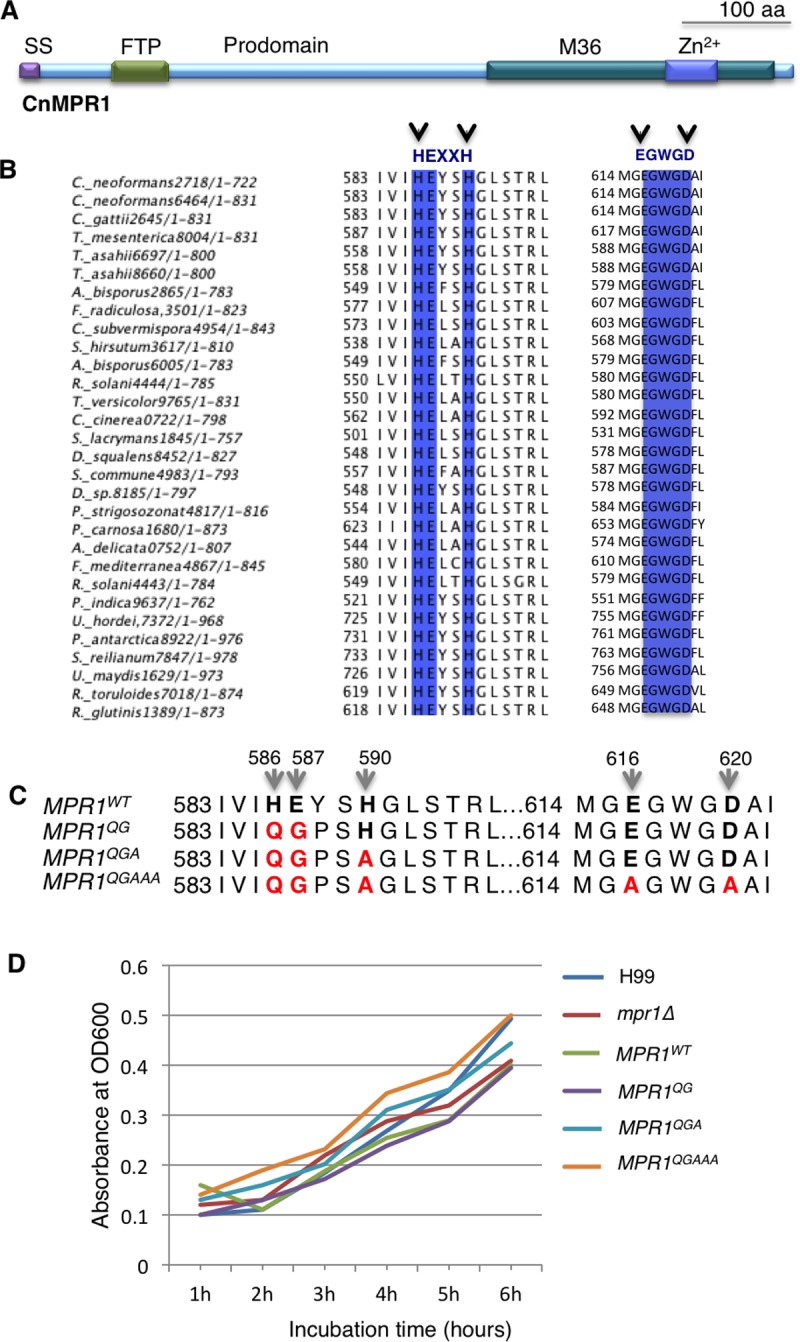
Substitution of conserved amino acids within regions of Mpr1 required for Zn2+ coordination and catalytic activity.(A) The scaled, schematic representation of the predicted structural features of Mpr1 indicates the signal sequence (SS), the prodomain containing a conserved FTP motif and the zinc-binding sites within the M36 catalytic domain. (B) The Mpr1 protein sequence alignment across fungal species revealed strong consensus among amino acids required for coordinating zinc and for catalytic activity (HExxH and ExxxD). (H, histidine; E, glutamic acid; D, aspartic acid). (C) Amino acid sequence depiction of wild type Mpr1 and three zinc-binding site mutants used in the study. MPR1wt is the reconstituted strain (mpr1Δ::MPR1) with conserved H586E587xxH590 and E616xxxD620 regions. The MPR1QG and MPR1QGA mutants contain amino acid substitutions within the HExxH consensus region as follows: H586Q, and E587G or H586Q, E587G and H590A. The MPR1QGAAA mutant contains substitutions in both HExxH and ExxxD consensus regions as follows: H586Q, E587G, H590A, E616A, D620A. (Q, glutamine; G, glycine; A, alanine). (D) The growth curves of C. neoformans strains expressing the MPR1 mutants demonstrated no significant difference in the growth rates at 37°C suggesting that expression of the MPR1 mutants did not negatively impact the viability of C. neoformans. The description of the MPR1 mutants is detailed above. The H99 strain represents a wild type strain of C. neoformans MPR1WT. The mpr1Δ deletion strain (constructed in an H99 background) was used as the background strain for the expression of each MPR1 mutant.